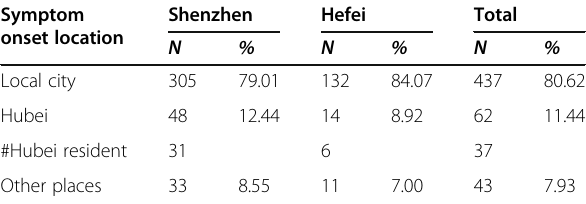
Table 3 Distribution of symptom onset locations Symptom onset